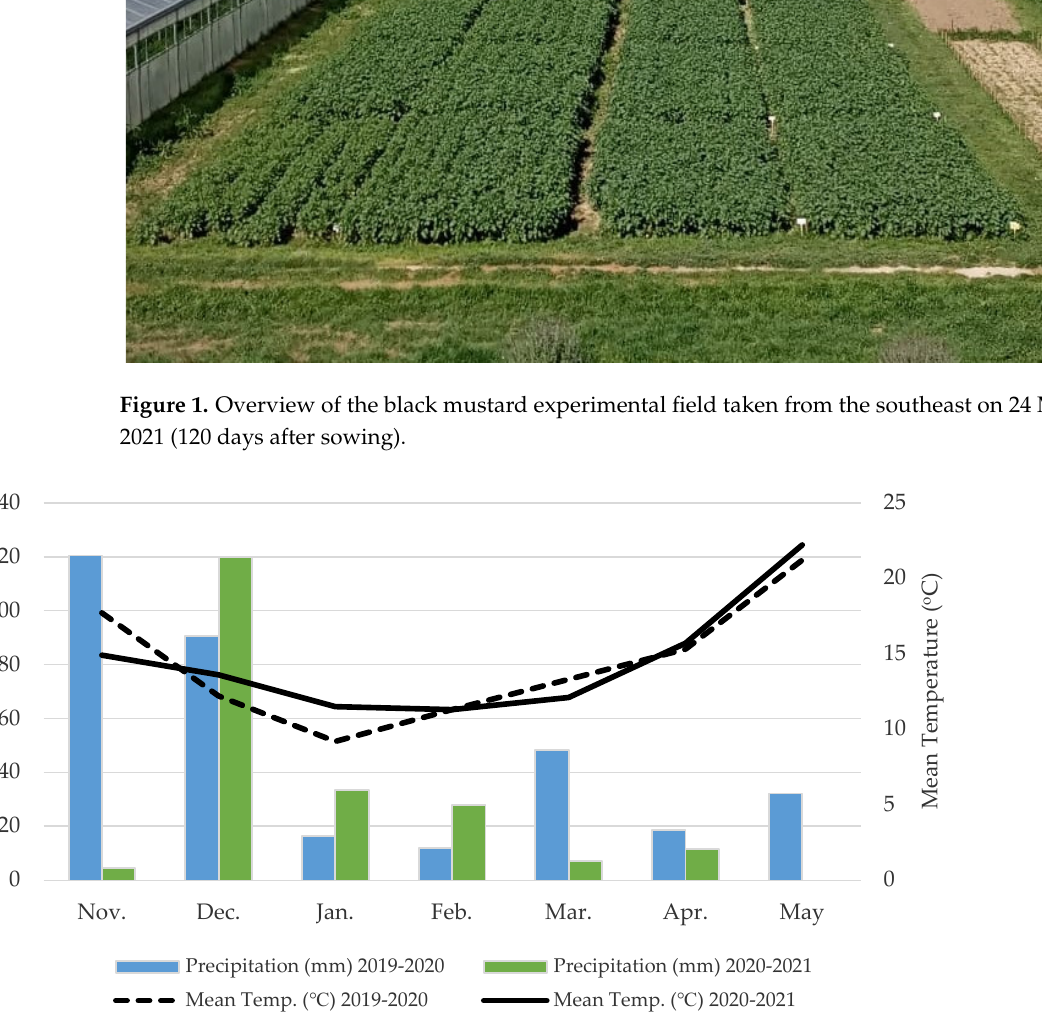
Figure 2. Meteorological data (mean monthly air temperature and precipitation) for experimental The experiment was set up on a 1015 m 2 area and arranged in a split-plot design, with 3 replications, in a 2 × 4 factorial scheme. The whole-plot factor was two different plant densities (PD1: 46 plants m − 2 and PD2: 76 plants m − 2 ), and the split-plot factor was four different fertilization types (untreated (Control), urea (U), urea with Nitrification and Urease Inhibitors (U + NI + UI) and seaweed compost (Compost)). The rate of each type of fertilizer used in the current study is the general recommended dose of the corresponding type of fertilizer for black mustard production in clay–loam soils [8,10,32]. Specifically, the total applied fertilizer dose for urea fertilizers with and without inhibitors was 140 kg N ha − 1 , while the nitrogen application rate for seaweed compost was 50 kg N ha − 1 . The type of urea fertilizer was 46 ‐ 0 ‐ 0. The nitrification inhibitor was N ‐ ((3(5) ‐ methyl ‐ 1H ‐ py ‐ razol ‐ 1 ‐ yl) methyl) acetamide (MPA; 0.07%) and the urease inhibitor was N ‐ (2 ‐ Nitro ‐ phenyl) phosphoric triamide (2 ‐ NPT; 0.035%) for the fertilizer with urea with double in ‐ hibitors (46 ‐ 0 ‐ 0). As for the seaweed compost, the N content was 1.98%. The main plot and sub ‐ plot sizes were 140 m 2 (35 m × 4 m) and 32 m 2 (8 m × 4 m), respectively. During each cultivation period, three days prior to the sowing, the soil was prepared by mouldboard ploughing at a depth of 25 cm. Fertilizers were applied as basal dressing through broad ‐ casting by hand and incorporated with the soil by harrowing. Black mustard [ Brassica nigra (L.) Koch] seeds were broadcasted by hand in rows 45 and 30 cm apart for PD1 and PD2, respectively, and 15 cm within each row. Seed sowing was performed on 29 and 24 November for the first and the second experimental year, respectively. The crop was har ‐ vested by hand on 6 June 2020 and 24 May 2021, when the seeds reached full maturity (seed moisture was approximately 9%). During the cropping periods, there was no inci ‐ dence of pests or disease in the black mustard crop. Moreover, weeds were controlled by hand ‐ hoeing when needed and before canopy closure. 4.2. Sampling Procedures, Measurements and Methods A total of 20 plant samples were randomly collected from each sub ‐ plot at the early flowering stage of black mustard, specifically at 120 days after sowing (DAS). Above ‐ ground dry matter (DM) was determined after drying for 48 h at 64 °C. Then, the DM weight of the whole plant and the yield per unit area were measured and calculated ac ‐ cording to the planting density. As for the chemical composition analysis, the plant samples were ground to pass through a 1 ‐ mm Wiley mill (Thomas T4274.E15 Steel Model 4 Wiley Mill; Arthur H.